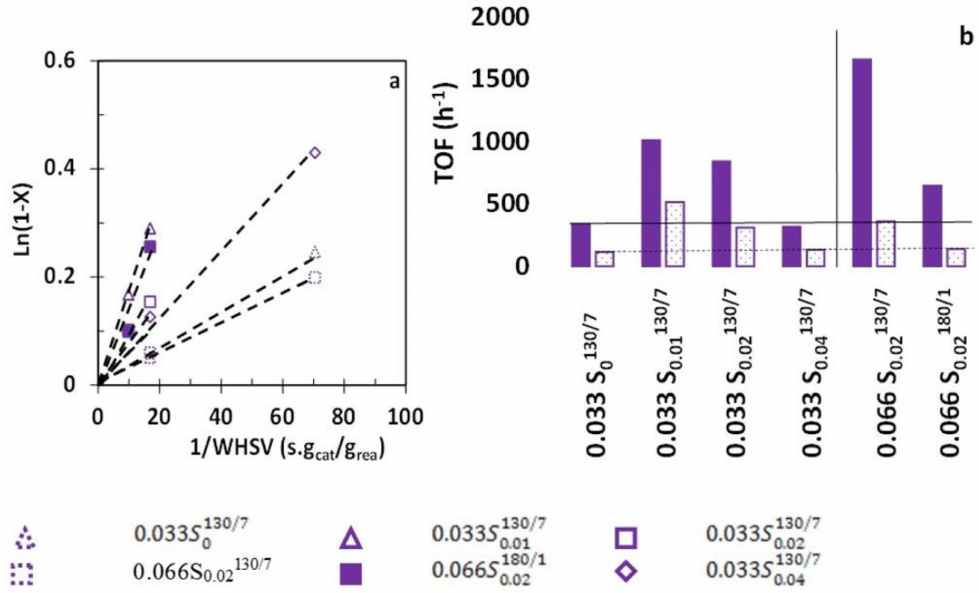
Figure 6. n -Hexane cracking: ( a ) Test for the first-order rate equation, ( b ) Turnover frequencies per theoretical (empty bar) and probed (full bar) Brønsted acid